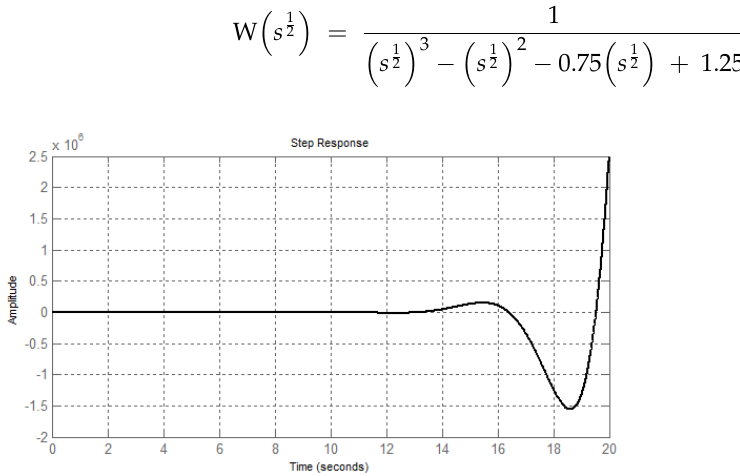
Figure 10. The transition function in this case.